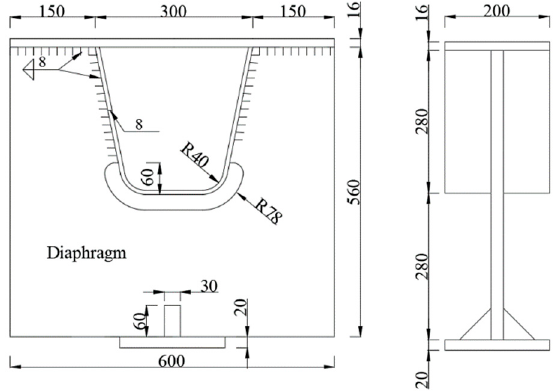
Figure 6. Schematic diagram of specimen (unit: mm).